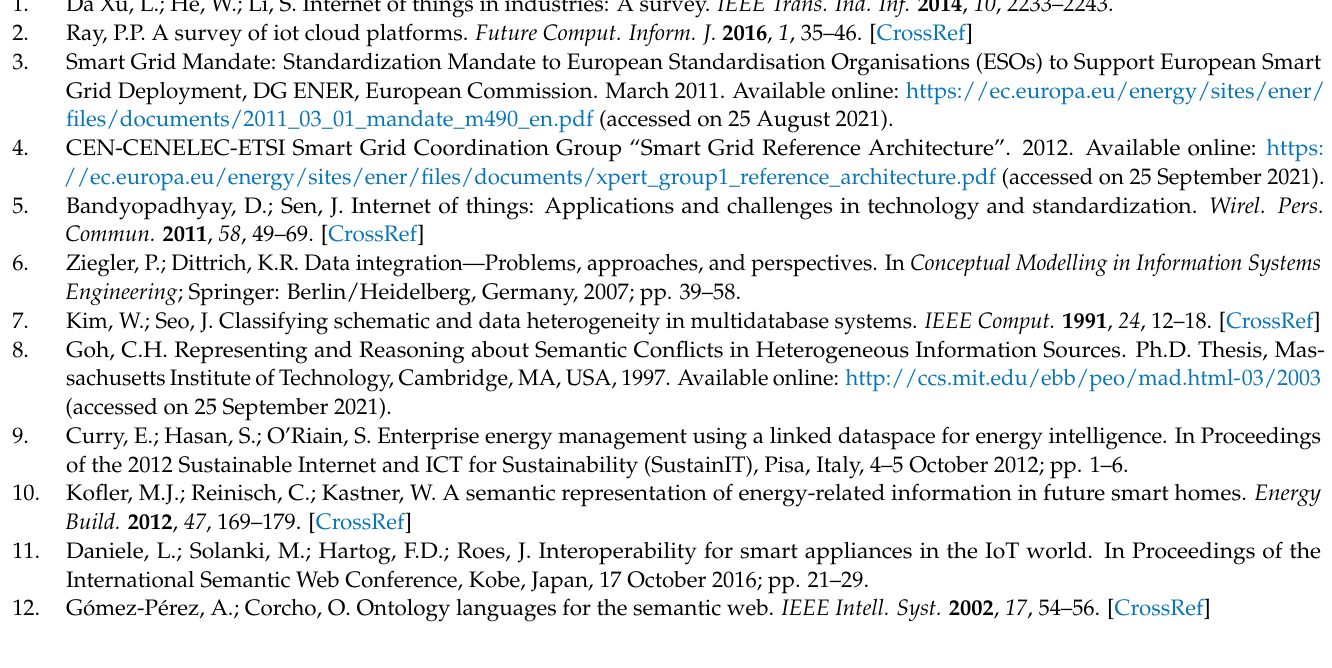
Figure A1. Annotated data of Floor